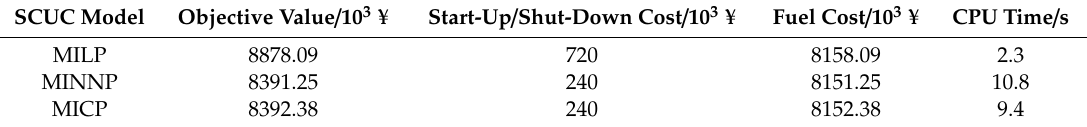
Table 4. Comparison of the